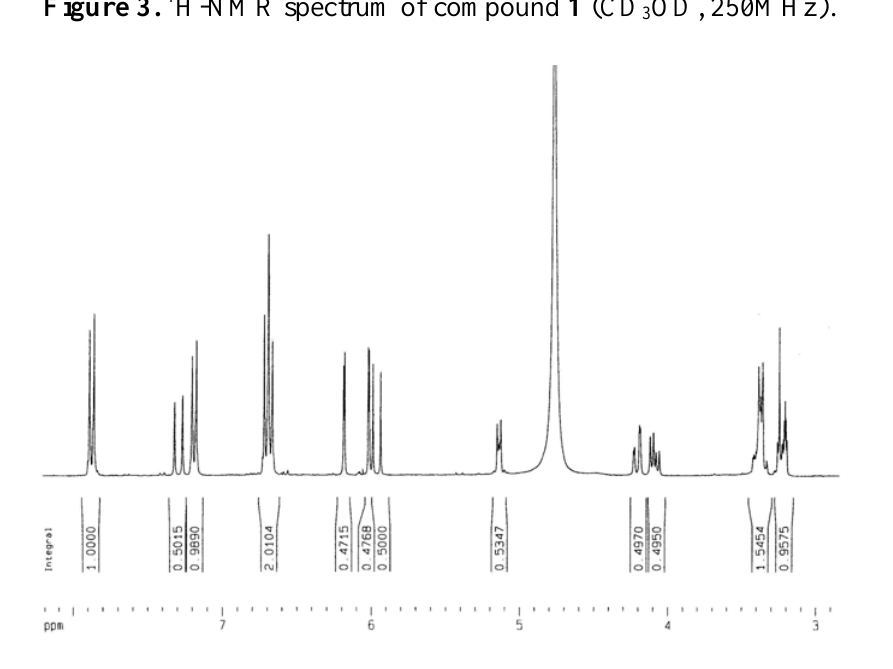
Figure 3. 1 H-NMR spectrum of compound 1 (CD